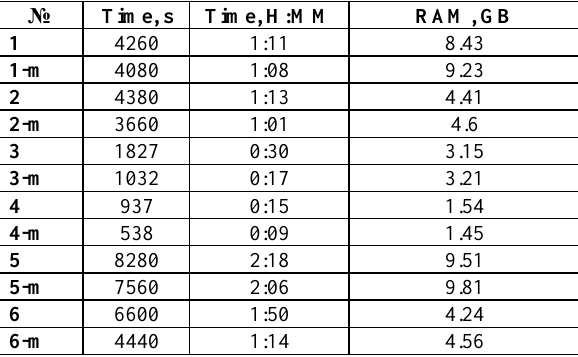
Table 5 . The resources